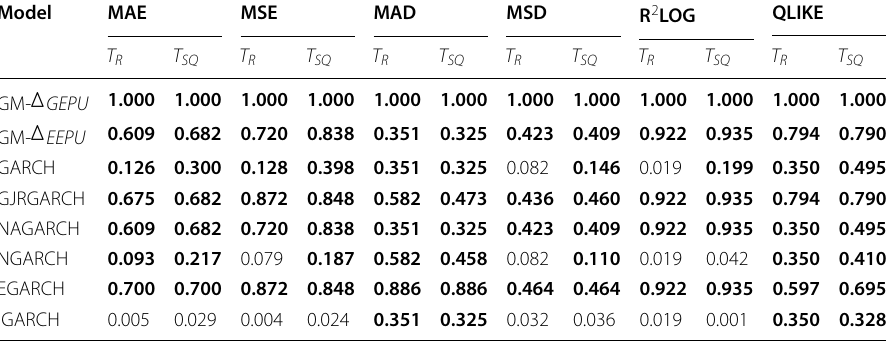
The bold numbers represent the models with p value greater than 0.1